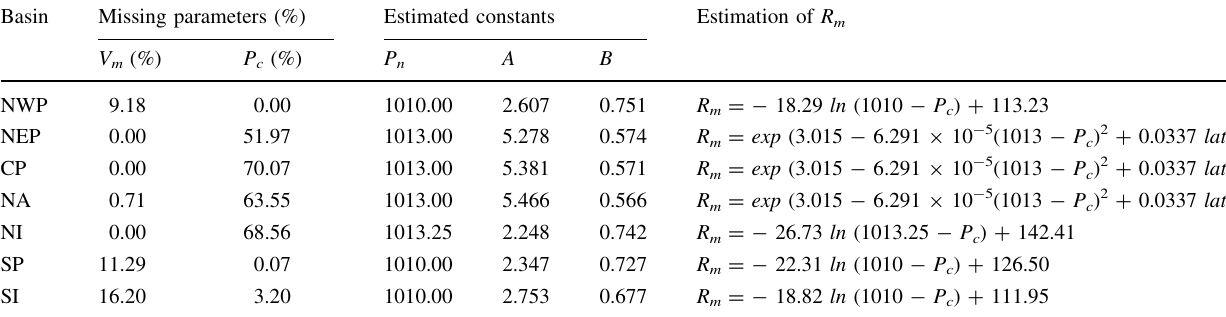
Ocean basins are: Northwest Pacific (NWP); Northeast Pacific (NEP); CP (Central Pacific); NA (North Atlantic); NI (North Indian); SP (South Pacific); SI (South Indian). Tropical storm parameters include mean wind velocity ( V m ), environmental pressure ( P n ), central pressure ( P c ), and